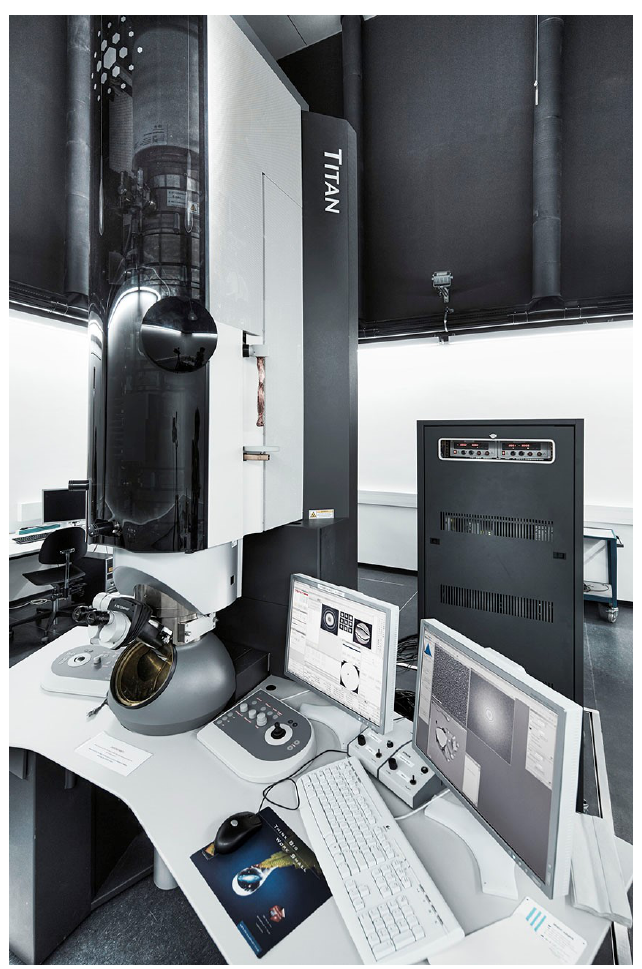
Figure 1: FEI Titan G2 60-300 HOLO transmission electron microscope (photograph by courtesy of Christian Lüning (www.arbeitsblende.de))